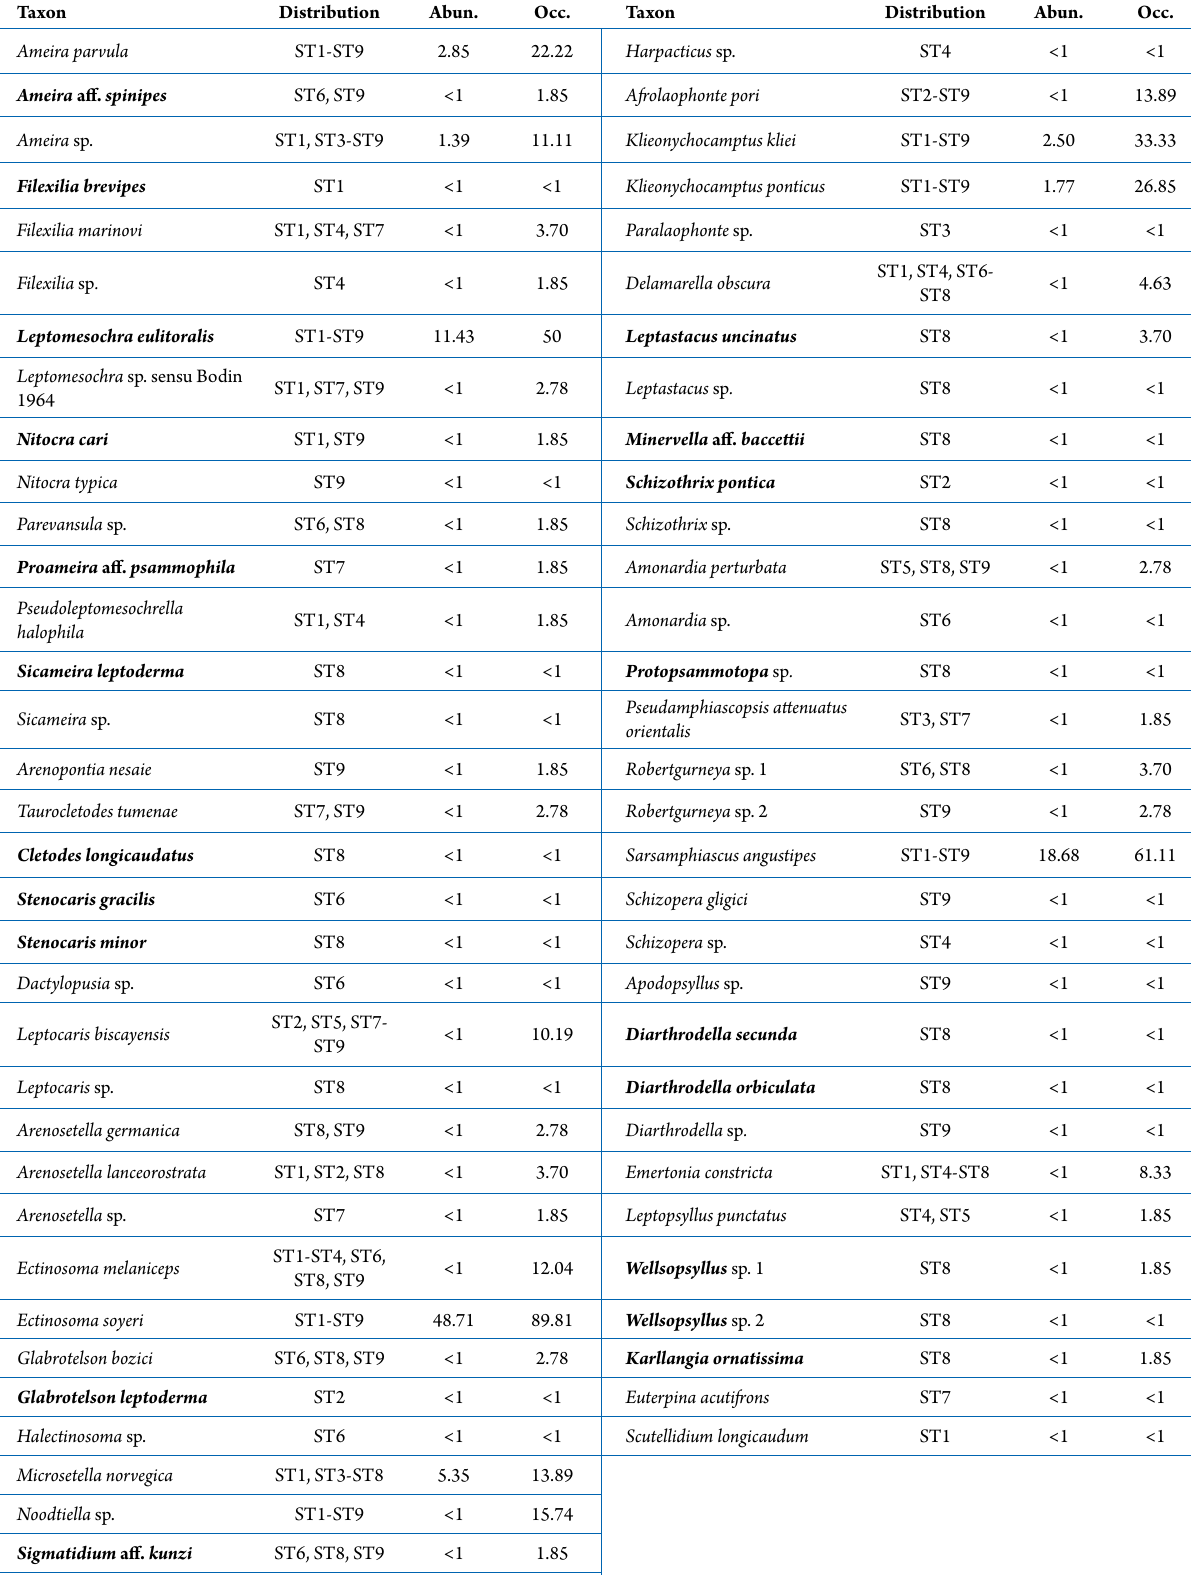
Table 4. Distribution, relative abundance [%] (Abun.) and relative frequency of occurrence [%] (Occ.) (N = 108) of adult harpacticoid species (boldface indicates new records for Turkish